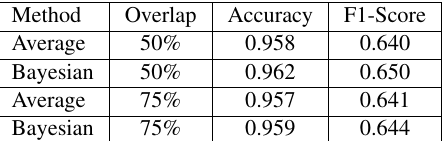
Table 5. Performance of the proposed Bayesian Fusion approach vs the usual Averaging method. Prior probabilities are set 0.2 for the SCD class and 0.8 for the “other”